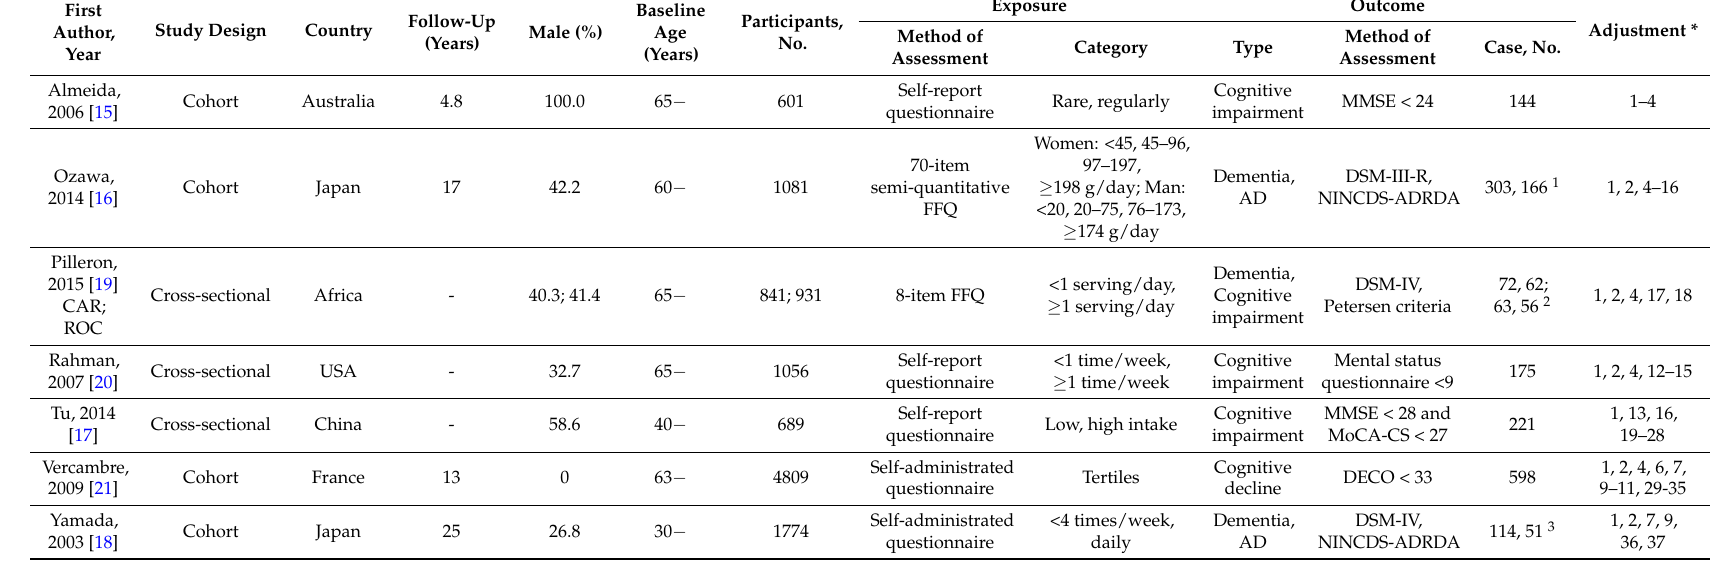
Table 1. Characteristics of included